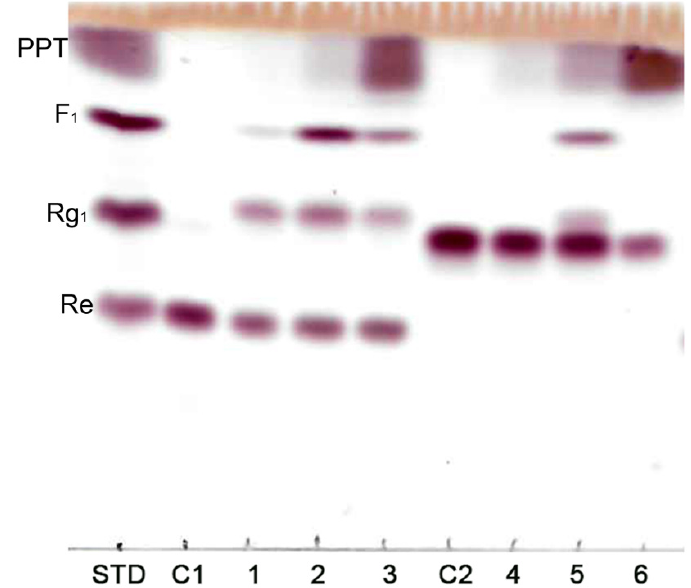
Figure 1. Thin layer chromatography of hydrolyzation products by MT619. C1, Re; 1, Re transformation products; 2, Re transformation products with F1 added; 3, Re transformation products with PPT added; C2, Rg 2 (S); 4, Rg 2 (S) transformation products; 5, Rg 2 (S) transformation products with F1 added; 6, Rg 2 (S) transformation products with PPT added.